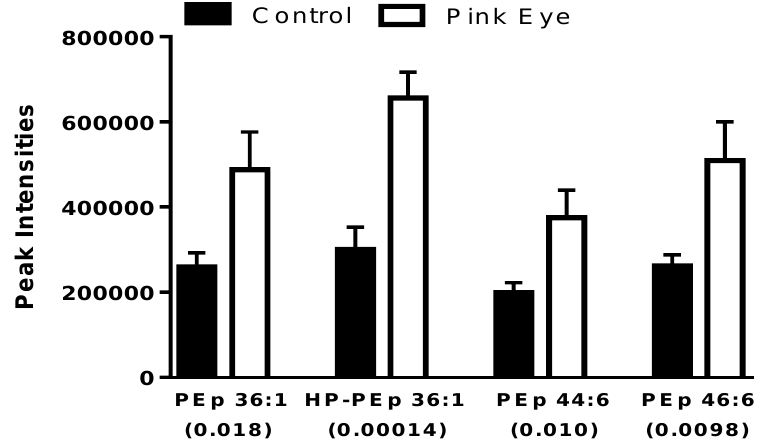
Figure 3. Ethanolamine plasmalogens in bovine tear fluid. Data are presented as peak intensities for the ions of each of the lipids ± SEM. HP, hydroperoxy; PEp, ethanolamine plasmalogen. p values are in brackets.